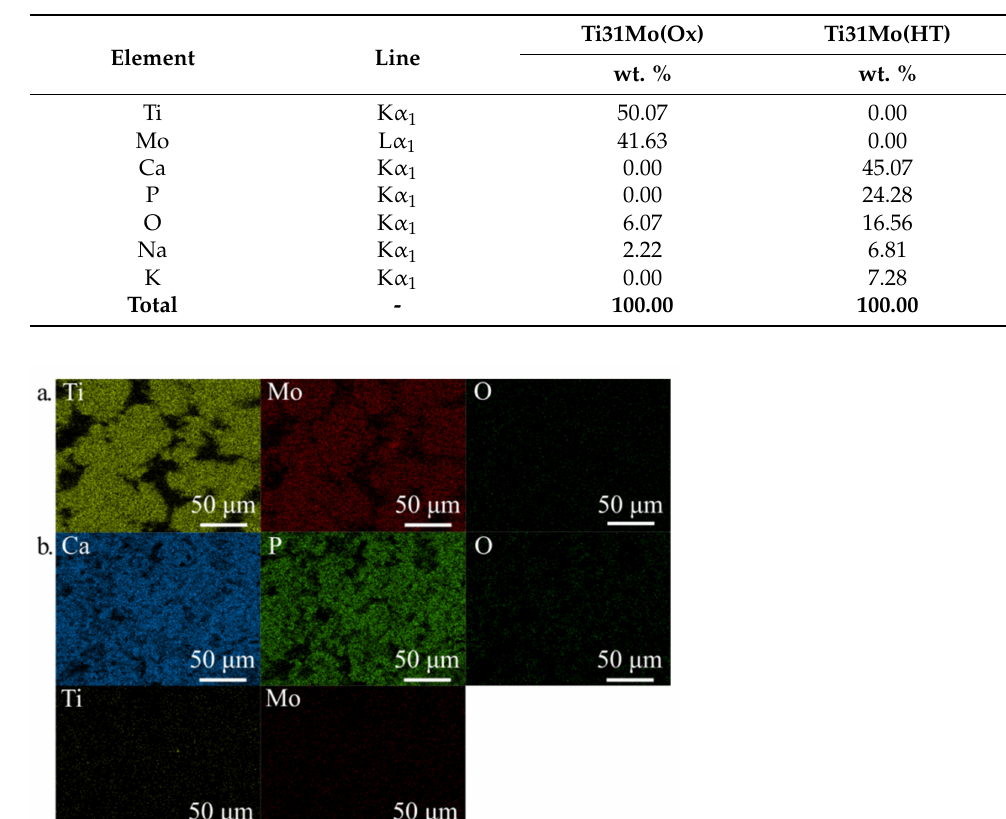
Table 2. Energy-dispersive spectrometer (EDS) results for Ti31Mo after NaOH 60 ◦ C/24 h and hydrothermal treatment.